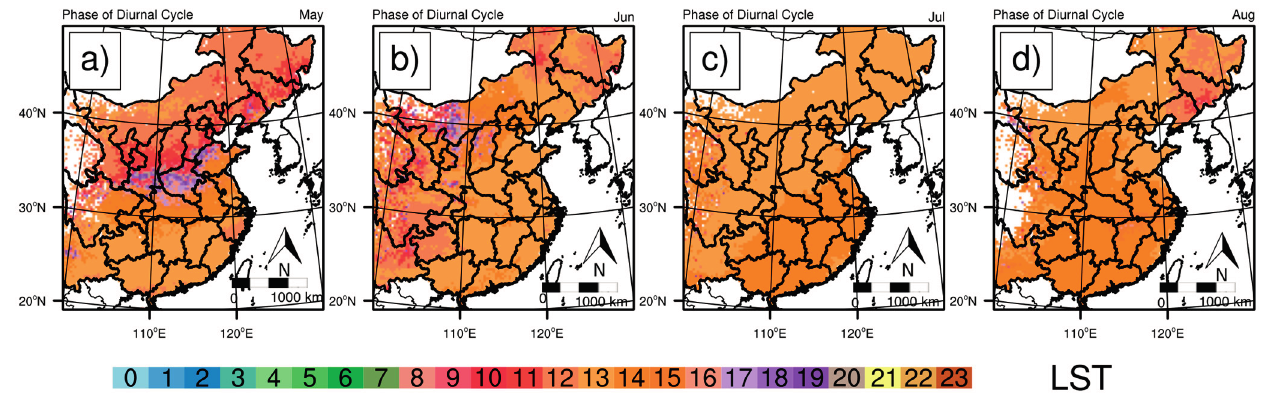
Figure 9. Time of the maximum PWV in a day calculated from the reconstructed PWV data: ( a ) May; ( b ) June; ( c ) July; and ( d ) August. Missing data or pixels out of the national map boundary are indicated as white